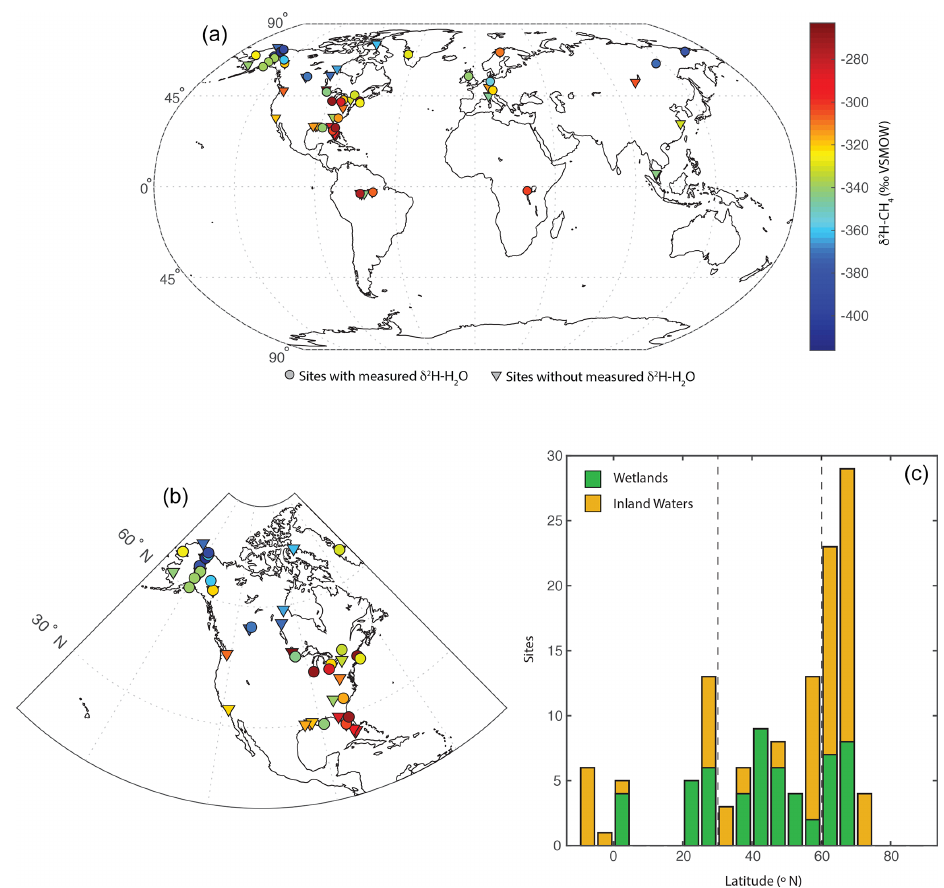
Figure 1. Distribution of sites shown (a) on a global map, with site mean CH 4 - δ 2 H values indicated in relation to a colour bar. Sites with and without measured δ 2 H–H 2 O are differentiated: (b) on a map of North America and (c) as a histogram of sites by latitude, differentiated between wetlands and inland waters. Dashed lines in (c) indicate divisions between low-latitude, mid-latitude, and high-latitude